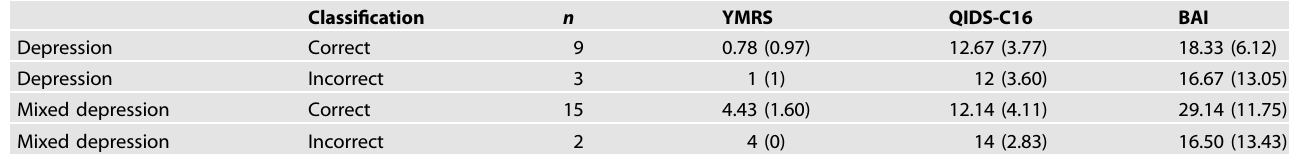
Table 3. Classi fi cation results in depression groups and descriptive clinical measures (mean and SD).